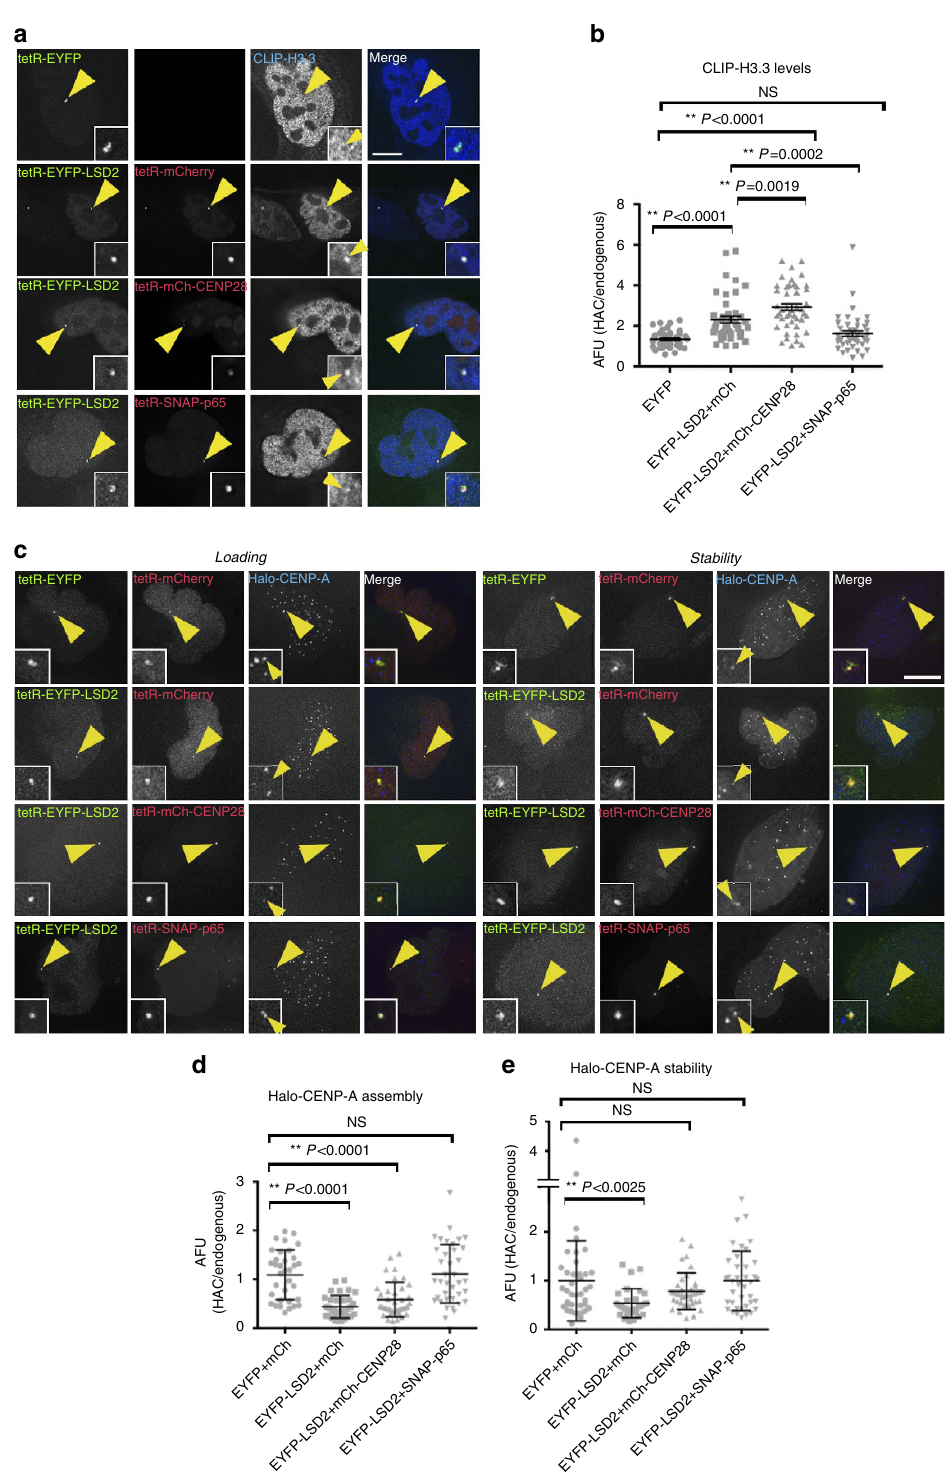
Figure 7 | Histone H3 modifications stabilize centrochromatin for kinetochore maintenance. ( a ) Immunofluorescence images of 1C7 cells expressing CLIP-H3.3 and the indicated tetR-fusion proteins for 48h. H3.3 was detected by staining for anti-CLIP (BC-Alexa647). Merged images represent the overlay of EYFP, mCherry/TMR-Star signals with Alexa647 (panel 4). ( b ) Quantification of fluorescence signals of HAC-associated CLIP-H3.3 staining in individual cells transfected with the indicated tetR-fusion constructs. Values for the HAC-associated CLIP-H3.3 signals were normalized for the mean of the H3.3 signals of the nuclei. ( c ) Representative images of 1C7 cells expressing Halo-CENP-A and the indicated tetR-fusion proteins for 48h. Halo-CENP-A was detected with a Coumarin-tagged Halo ligand. Left panels show the loading of newly synthesized Halo-CENP-A and the right panels show levels of total Halo-CENP-A molecules at centromeres. ( d , e ) Quantification of Coumarin fluorescence signal associated with the HAC and normalized to the average signals at endogenous centromeres. Solid bars indicate the medians and error bars represent the s.e.m. N ¼ three independent experiments. Scale bars, 10 m